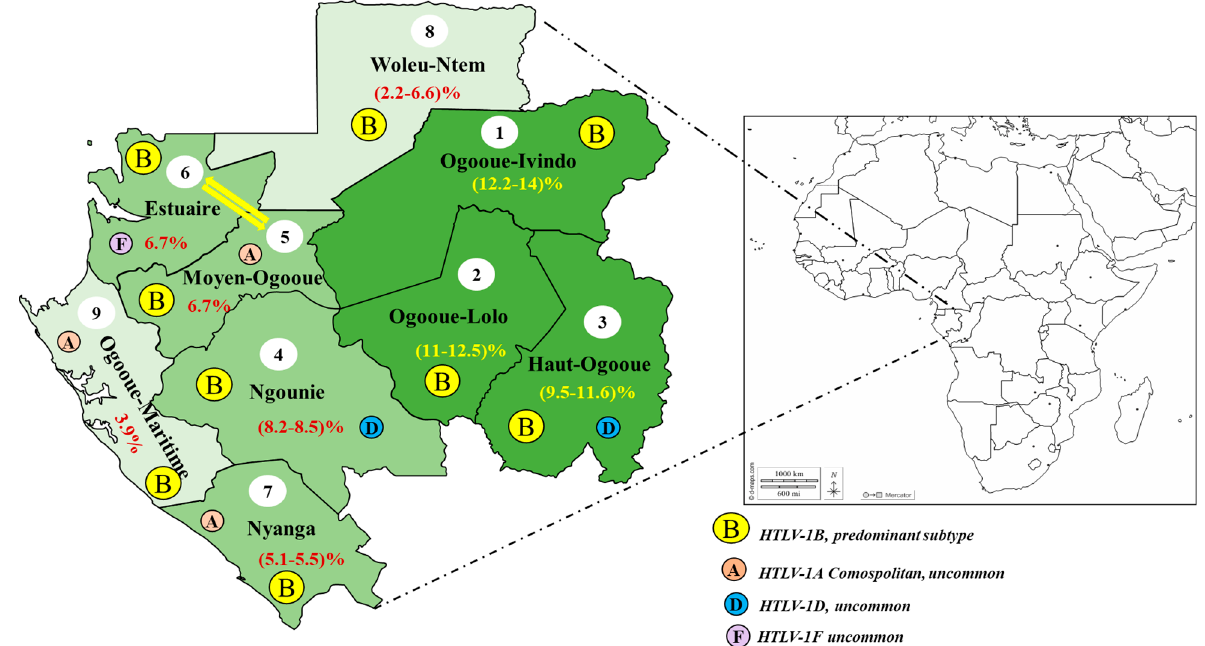
Figure 2. HTLV-1 distribution, according to prevalence of each province and the viral subtype described [11,12,45–48]. Numbers in brackets are the HTLV-1 prevalence in each province. Thus, the provinces are classified accordingly to the prevalence; number 1 is the highest and 9 is the lowest. Letters indicate the described HTLV-1 subtype in each province.